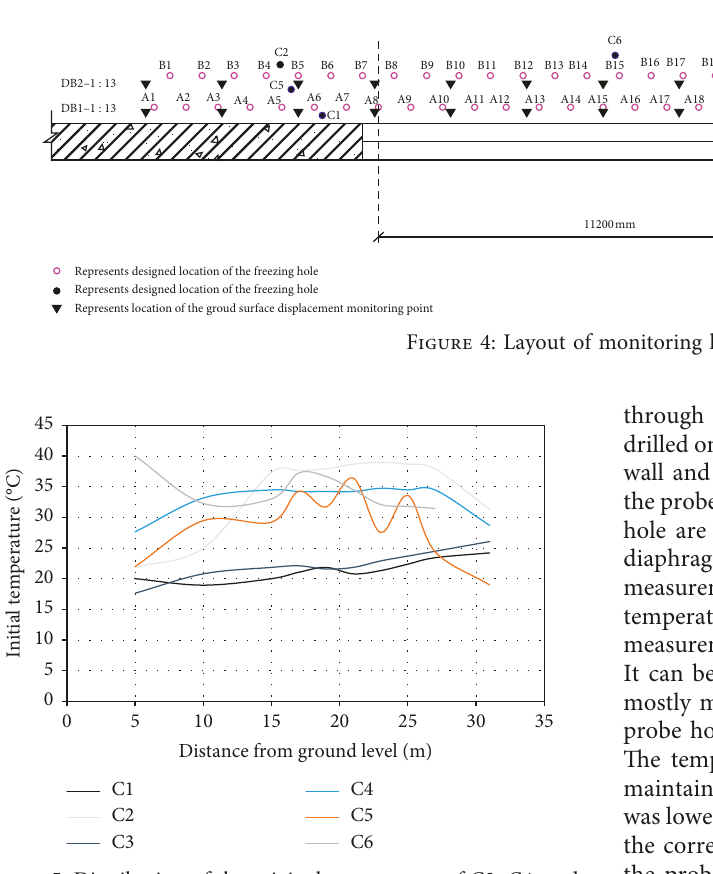
Figure 5: Distribution of the original temperature of C2, C4, and C6.